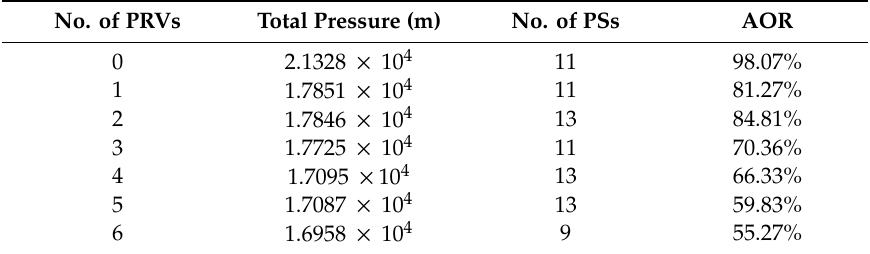
Table 5. Total pressure (24h) with PRVs for the WDS benchmark with 24 demand